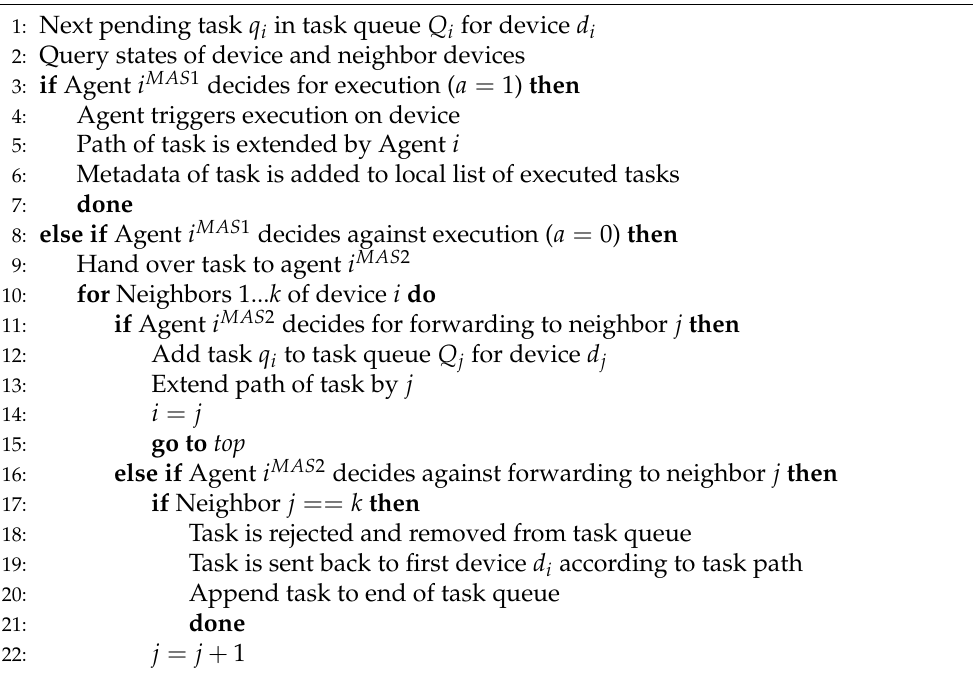
Algorithm 3 Interaction of MAS1 and